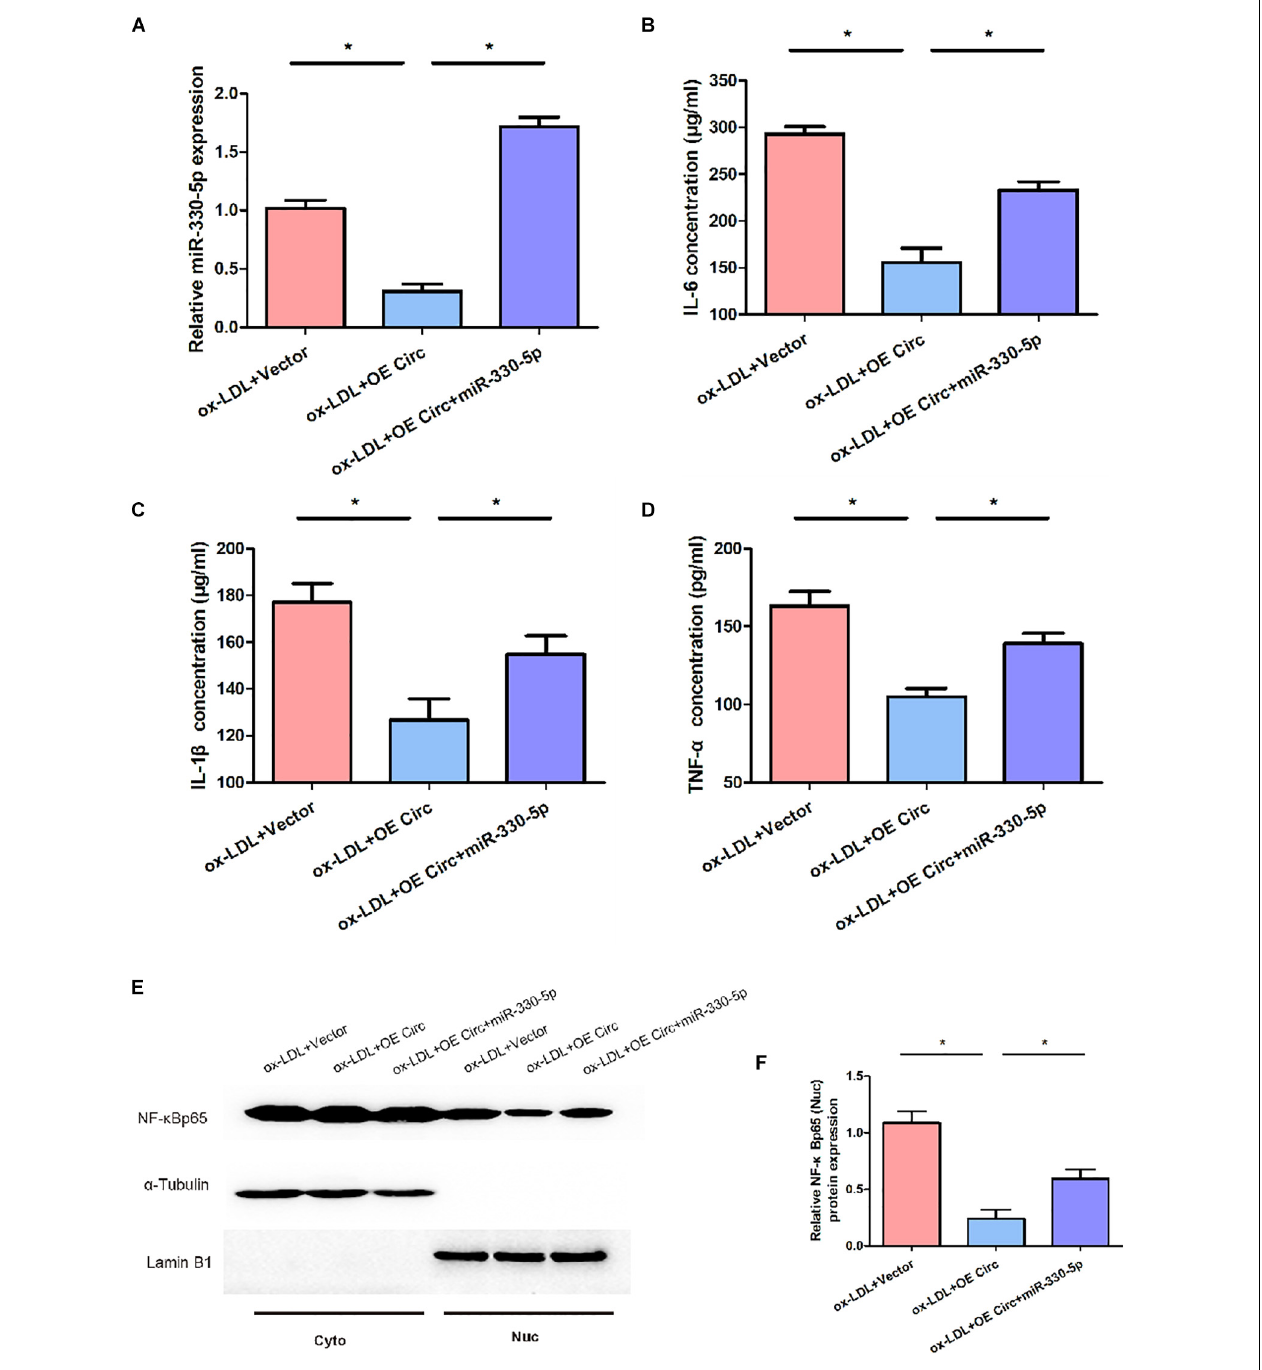
FIGURE 5 | Effect of miR-330-5p on the levels of NF- κ B and proinflammatory cytokines in ox-LDL-induced HUVECs. (A) Expression of miR-330-5p in ox-LDL-induced HUVECs. MiR-330-5p mimic increased the expressions of IL-6 (B) , IL-1 β (C) , TNF- α (D) in ox-LDL-induced HUVECs. (E,F) MiR-330-5p mimic restored the nuclear expression of NF- κ Bp65 in ox-LDL-induced HUVECs. The expression of NF- κ Bp65 was assessed in the nuclear and cytoplasmic fractions. Data are shown as means ± SD . * P < 0.05, ox-LDL + OE Circ vs. the ox-LDL Vector group; ox-LDL + OE Circ + miR330-5p vs. the ox-LDL Vector